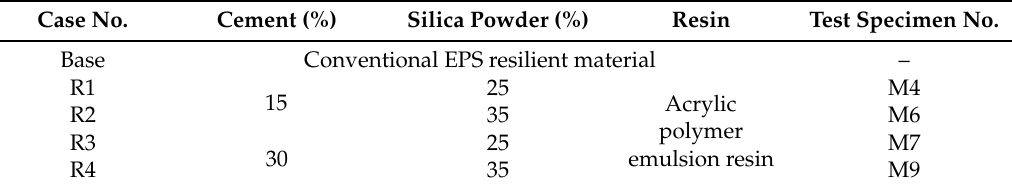
Table 10. Mix ratio of resilient materials for floor impact noise testing.